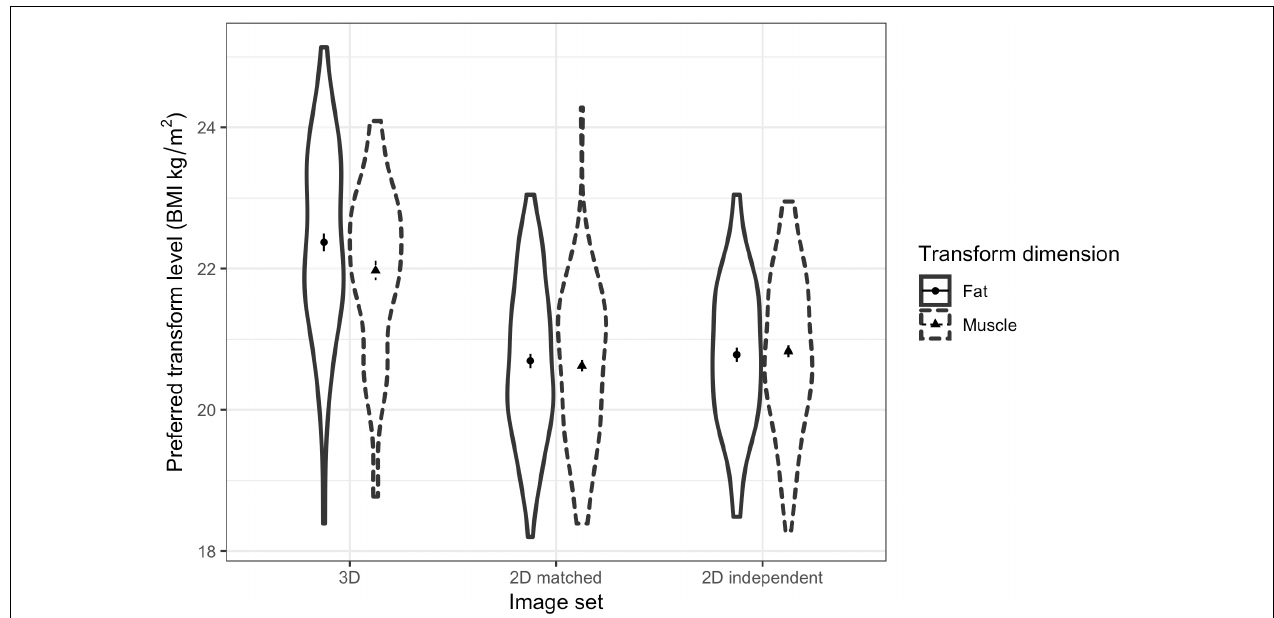
FIGURE 9 | Violin plots showing the distribution of MTurk women’s preferences for the facial correlates of fat mass and muscle mass in men. The vertical axis represents the associated BMI of the most preferred faces chosen by the women in short-term and long-term contexts. The error bars represent the standard errors and the symbols indicate